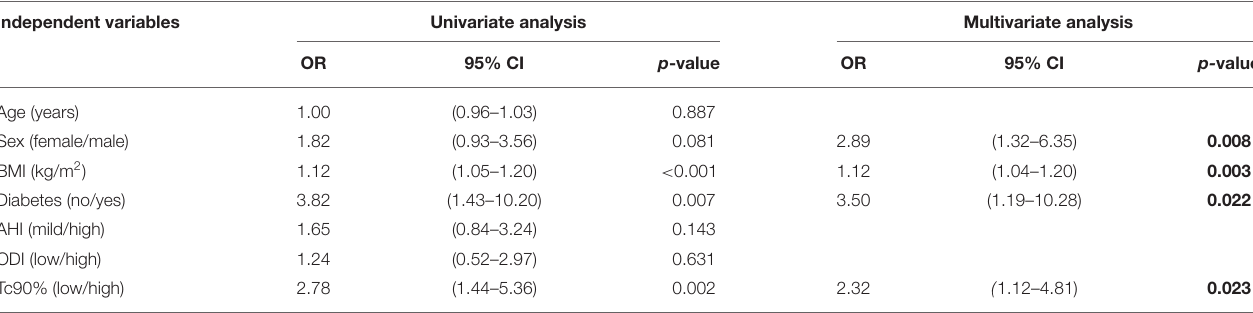
TABLE 4 | Univariate and multivariate analysis of the independent variables associated with non-alcoholic steatohepatitis (NASH) in patients with obstructive sleep apnea (OSA) ( n = 153). Independent